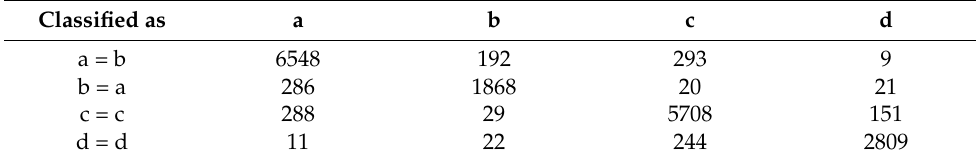
Table A3. The confusion matrix for apparent slip set as outlet variable.